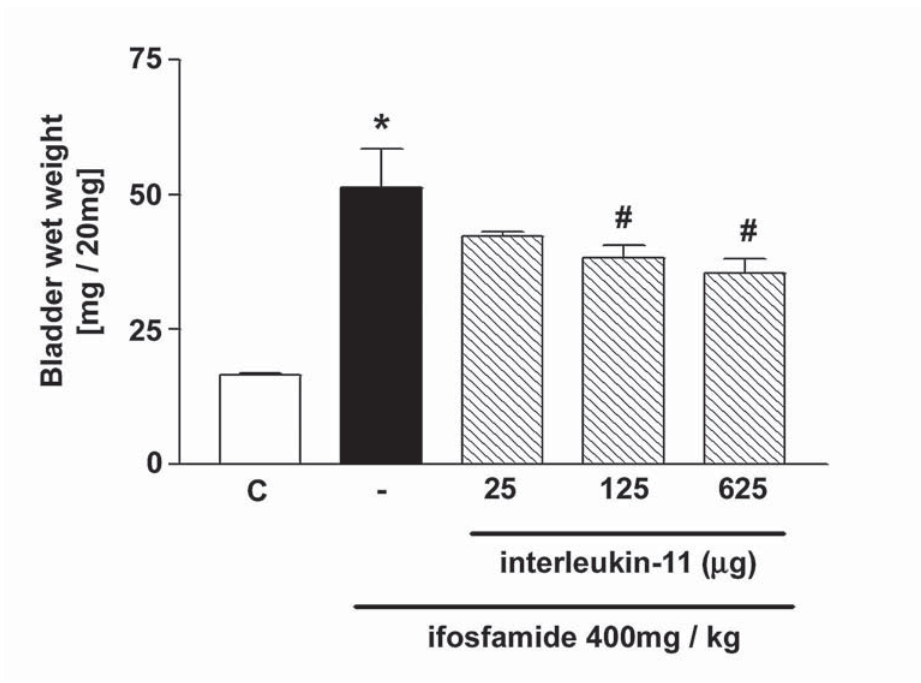
Figure 1 – Protective effect of rhIL-11 against ifosfamide-induced bladder wet weight increase. Ifosfamide at 400 mg/kg induced an increase in BWW when compared to the control group (C), and rhIL-11 at 125 µ g and 625 µ g protected against this side effect. * p < 0.05 compared with control group. # p < 0.05 compared to ifosfamide only group. ANOVA followed by